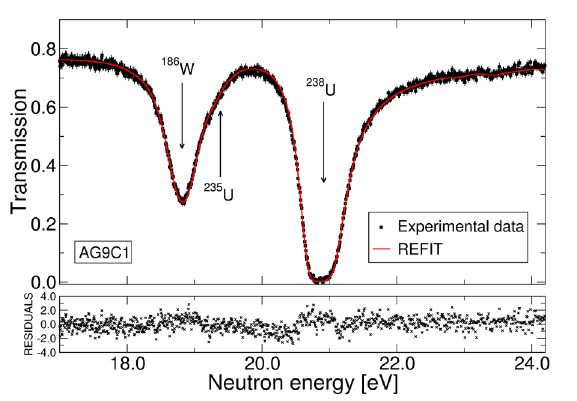
Figure 6. Transmission spectra of the AG9C1 sample in the vicinity of the 186 W resonance at 18.8